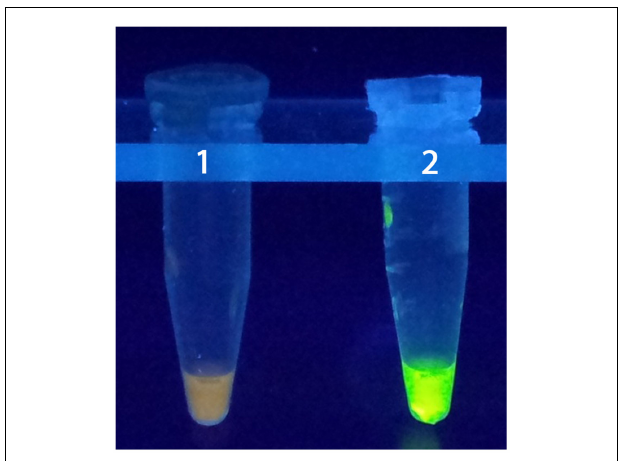
FIGURE 3 | LAMP test . 1: negative control, 2: positive control